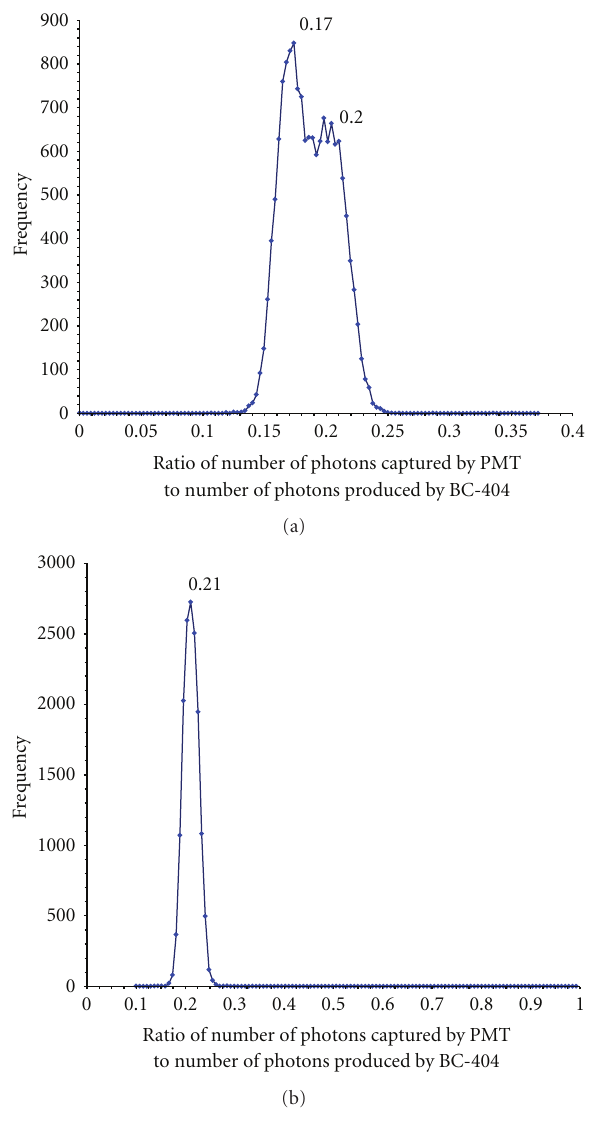
Figure 3: The BC404 photon counting histogram analysis for optimizing detector design parameters, (a) the worst-case scenario and (b) the best-case